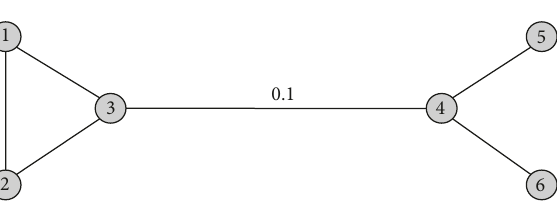
Figure 3: Second graph where default edge weight is 1.